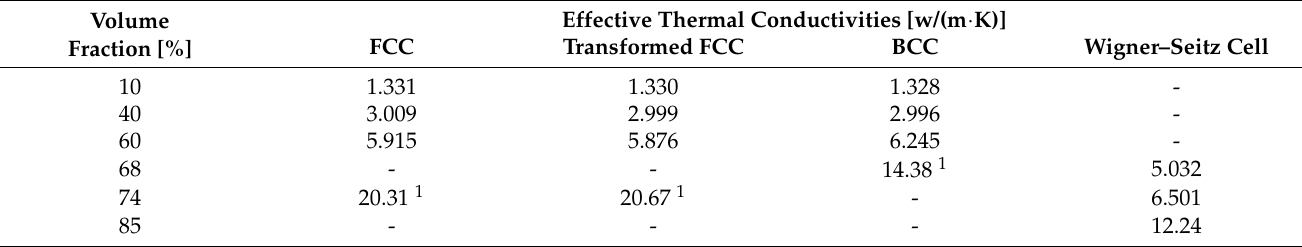
Table 2. Thermal conductivities of composites obtained from the